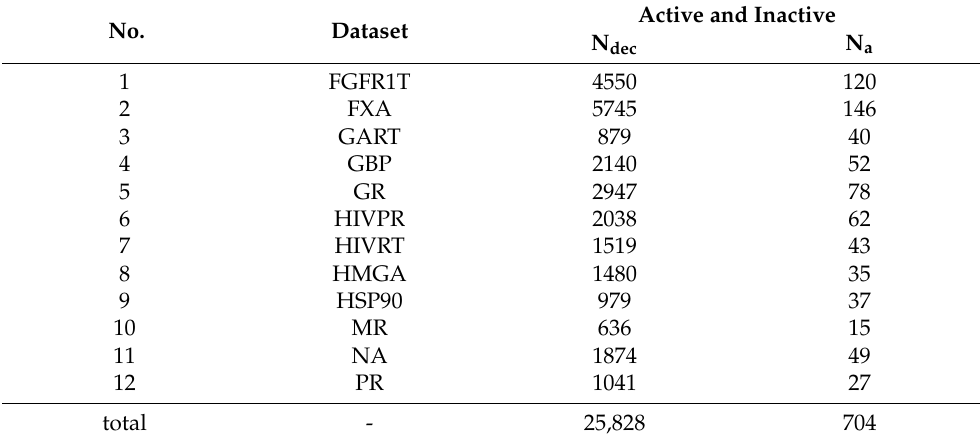
Table 5. DUD structure activity classes, where N a denotes the number of active compounds, and N dec denotes the number of